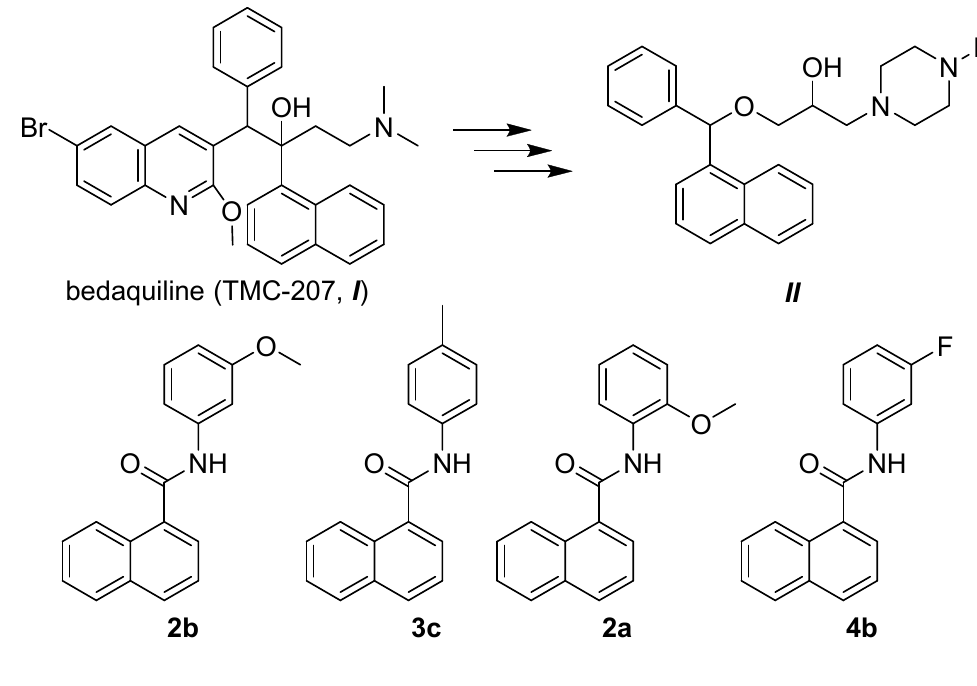
Figure 4. Structural analogy of the most effective compounds 2a , 2b , 3c , 4b to bedaquiline (TMC-207, I ) and its naphthalene analogues ( II )